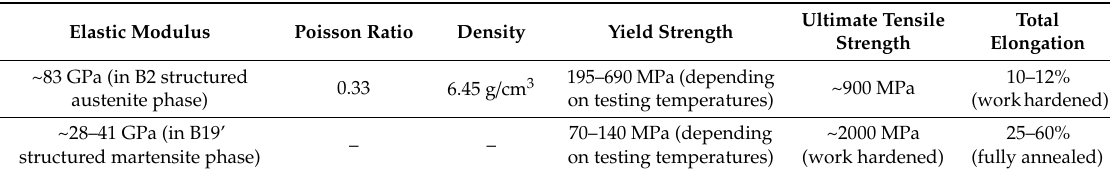
Table 1. Physical properties of NiTi alloys.